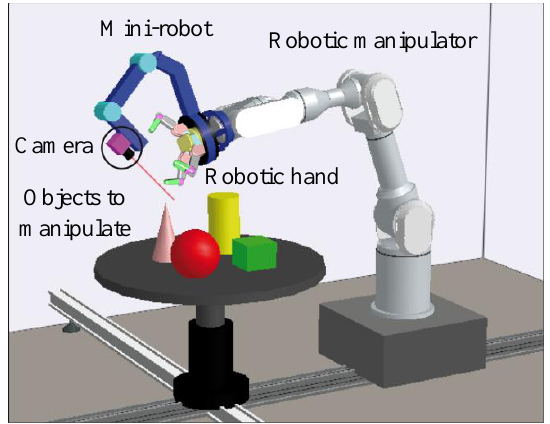
Figure 1. Multi-robot system composed of the robotic manipulator and the coupled mini-robot with a camera in an eye-in-hand configuration.